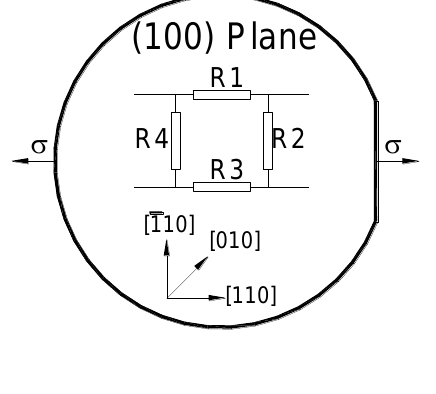
Figure 4. Schematic of the piezoresistive elements arrangement on (100) silicon substrate.